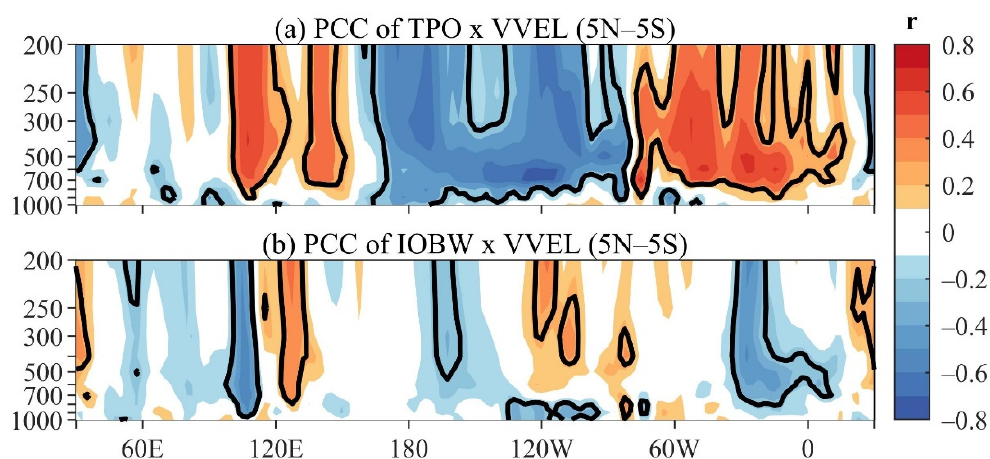
Figure 4. Longitude vertical cross-sections of the partial correlations for the vertical velocity in pressure coordinate averaged in the 5 ◦ N-5 ◦ S band (VVEL) during southern summer: ( a ) TPO and VVEL; ( b ) IOBW and VVEL. Continuous line encompasses significant correlations at a 95% confidence level using Student’s t -test. The vertical pressure levels are in hPa.